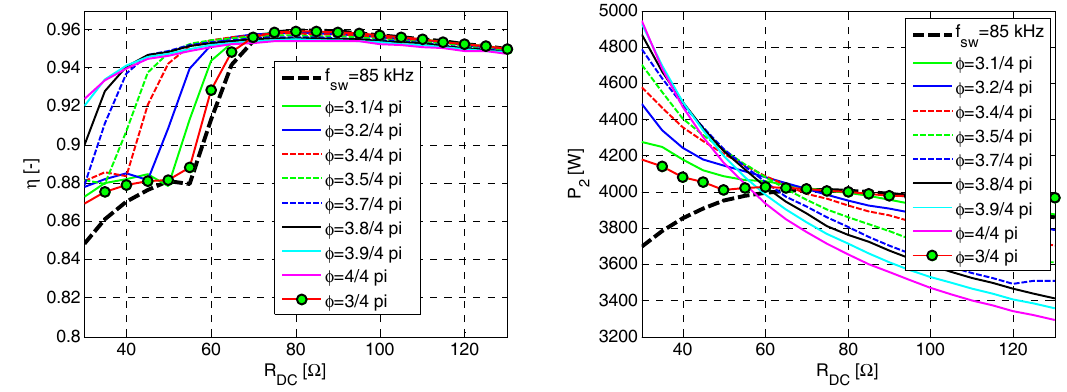
Figure 16. Efficiency ( left ) and power delivered to the load ( right ) when various phase-shift control used—operational distance 20 cm.